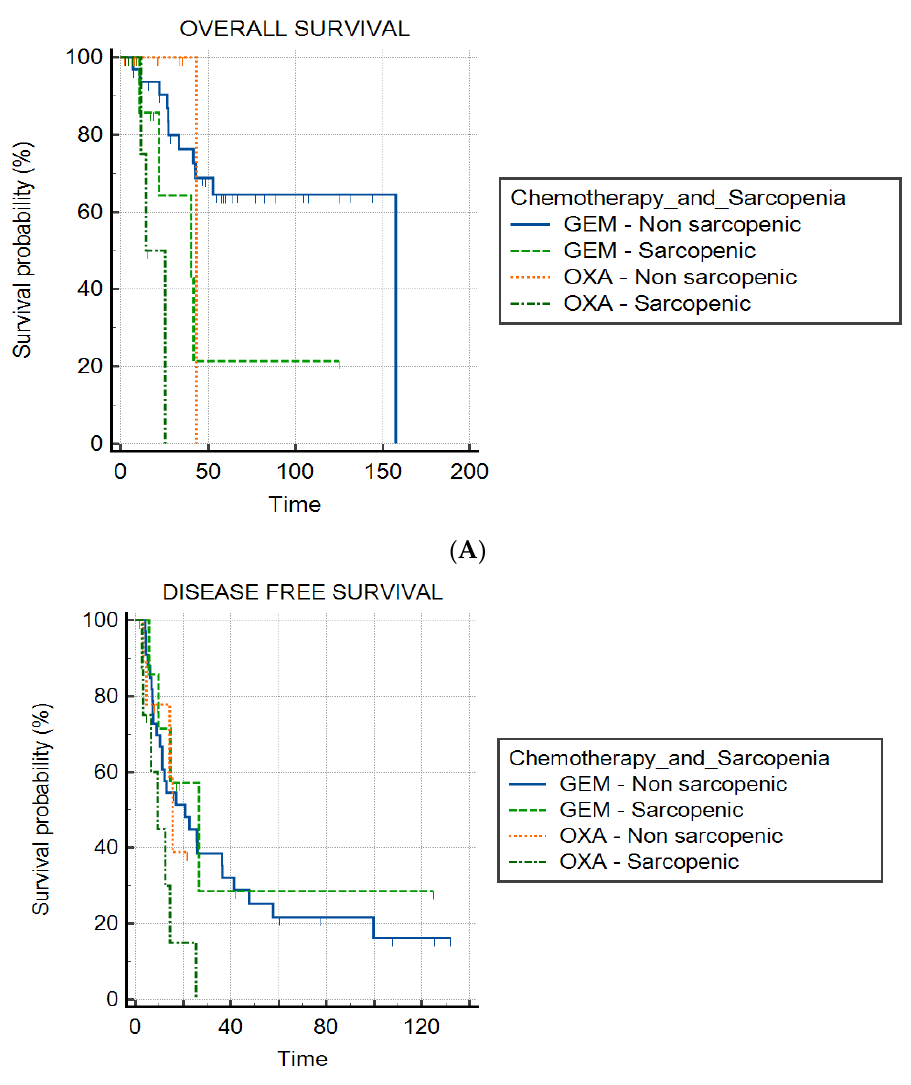
Figure 5. Graphs show Kaplan–Meier estimates of overall survival (OS) and disease-free survival (DFS) according to sarcopenia status and type of chemotherapy. ( A ) Median OS was 157.7 months for the GEM non-sarcopenic group, 43.4 months for the OXA non-sarcopenic group, 40.4 months for the GEM sarcopenic group and 14.4 months for the OXA sarcopenic group ( p < 0.01). ( B ) Median DFS was 26.6 months in the GEM sarcopenic group, 20.9 months in the GEM non-sarcopenic group, 15.6 months in the OXA non-sarcopenic group and 9.3 months in the OXA sarcopenic group ( p = 0.07). Tick marks indicate censored data. Time is expressed in months.